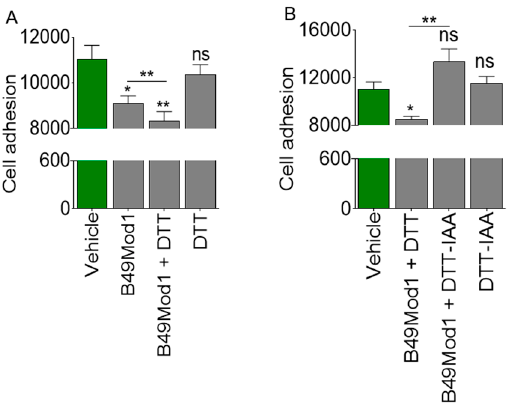
Figure 2. Disulfide (S-S) bond plays a role in B49Mod1-mediated inhibition of cell adhesion. ( A ) Adhesion of 4T1 cells was inhibited by B49Mod1 in the presence of unquenched S-S reducing agent 1,4-Dithiothreitol (DTT). ( B ) Adhesion of 4T1 cells was rescued in reactions in which free cysteine residues were alkylated by the Iodoacetic acid (IAA) following the reduction of S-S by DTT. Experiments were repeated three times with similar results. Error bars represent S.E.M. Ordinary